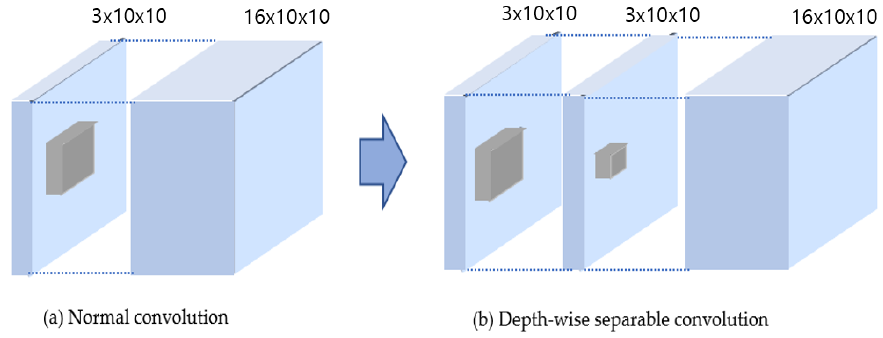
Figure 5. Comparison of ( a ) normal convolution and ( b ) separable convolution [12]. In Equation (1), D K represents the kernel size, D F represents the size of the input image, M represents the input channel, and N represents the output channel. Cost represents the number of computations.